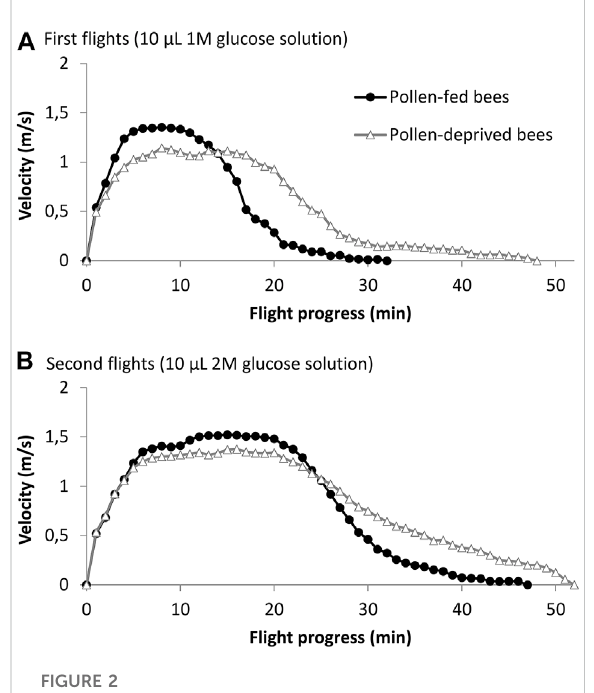
FIGURE 2 Mean fl ightspeedofpollen-fedandpollen-deprivedbees. (A) After being fed 10 μ L of 1 M glucose solution ( n = 23 bees per group) and (B) 10 μ L of 2 M glucose solution ( n = 23 pollen-fed bees and 18 pollen-deprived bees).